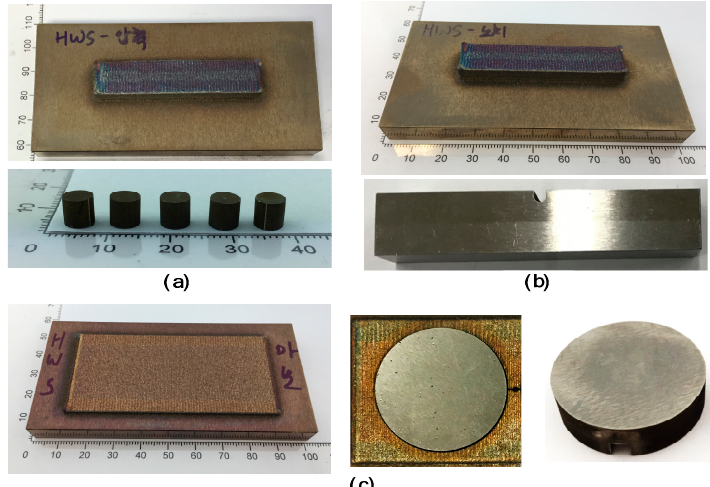
Figure 4. Foundation specimens and machined specimen with semi-AM heterogeneous materials: ( a ) Basic specimen before machining for the compression test and the finished specimen after machining; ( b ) Basic specimen for the impact test specimens and the finished specimen after machining; ( c ) Basic specimen before machining and the finished wear specimen after machining.